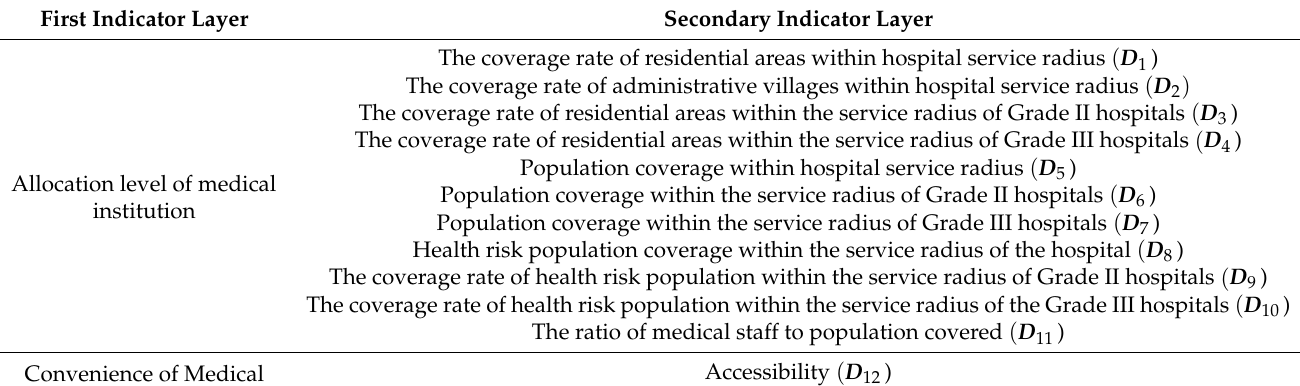
Table 2. Evaluation Indicator System for Equalization of Basic Medical